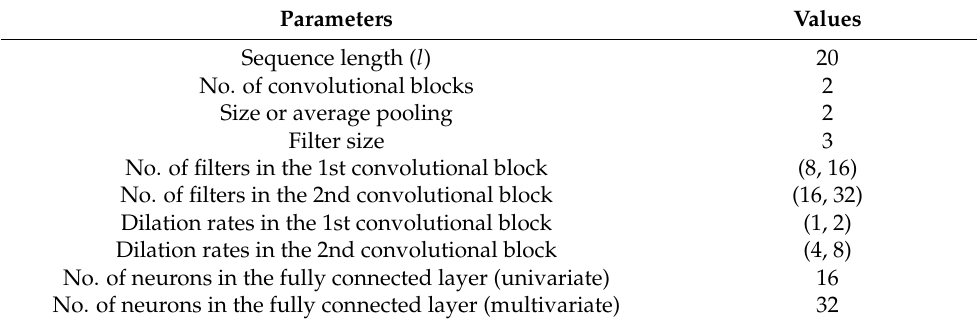
Table 1. Selected hyperparameters for univariate/multivariate 1D CNN